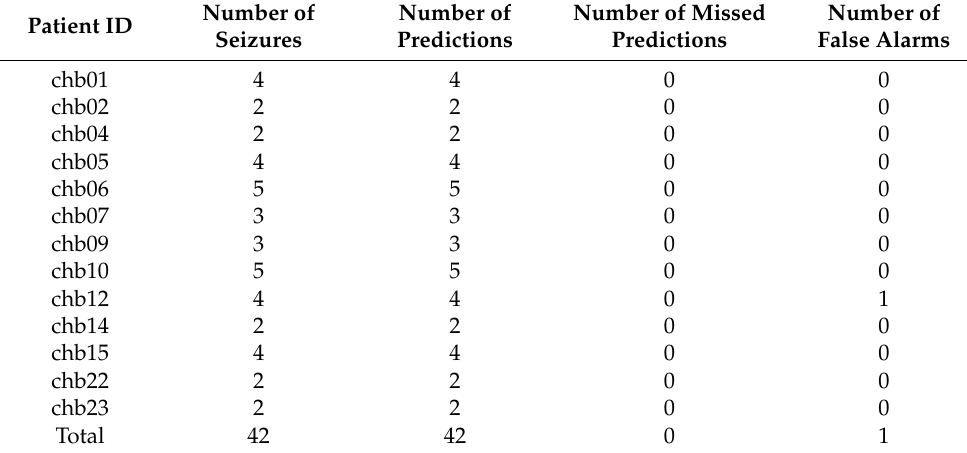
Table 6. Prediction results (InT = 40